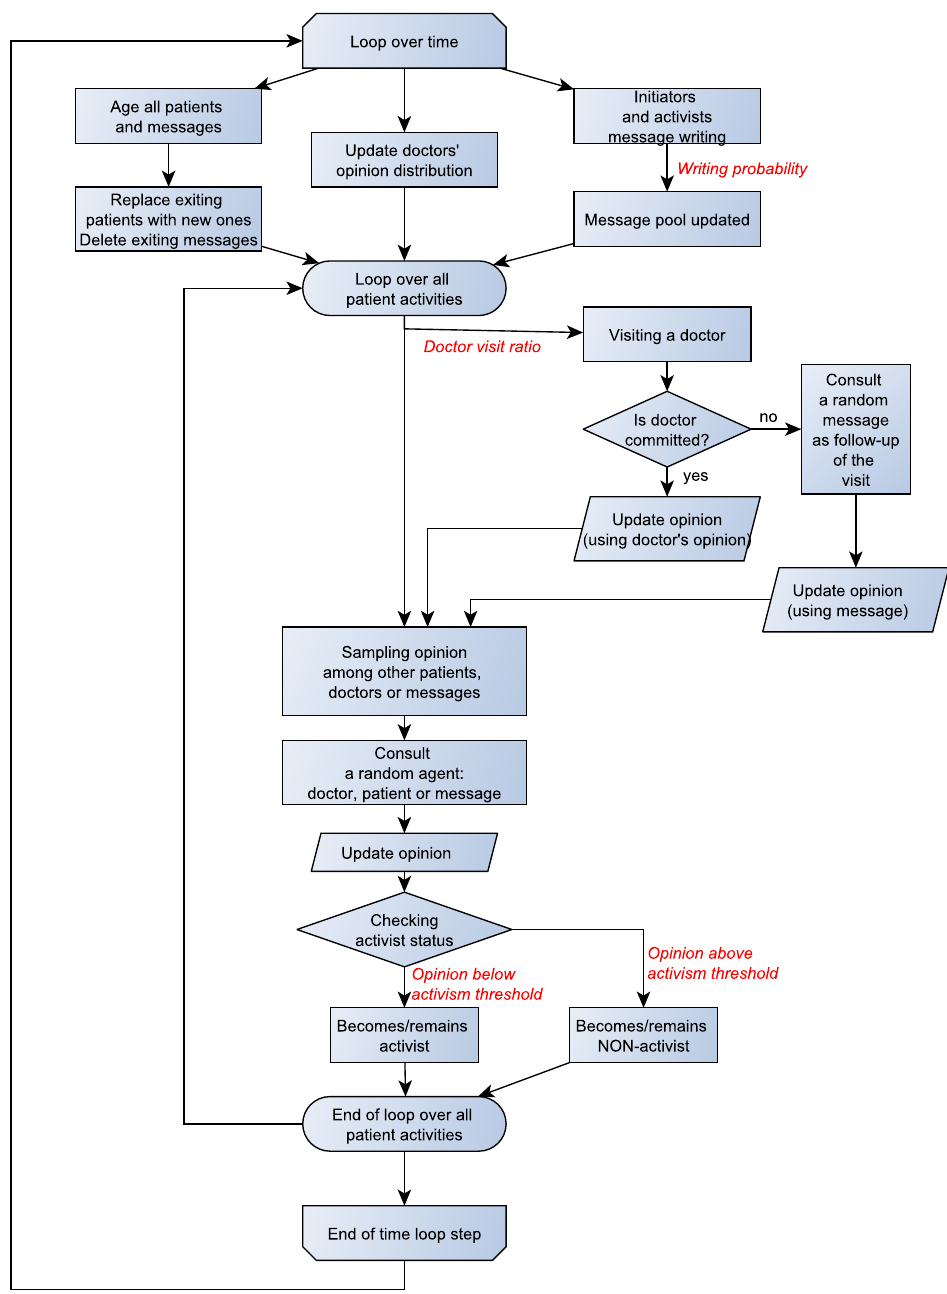
Figure 1. Flowchart of the opinion update process. Red text denotes the key control variables of the